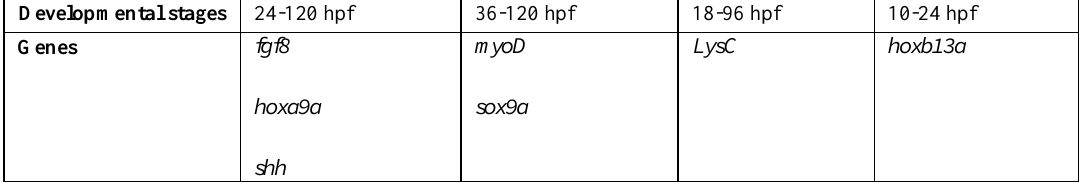
Table 4: This table shows the temporal relationship between genes of the selected